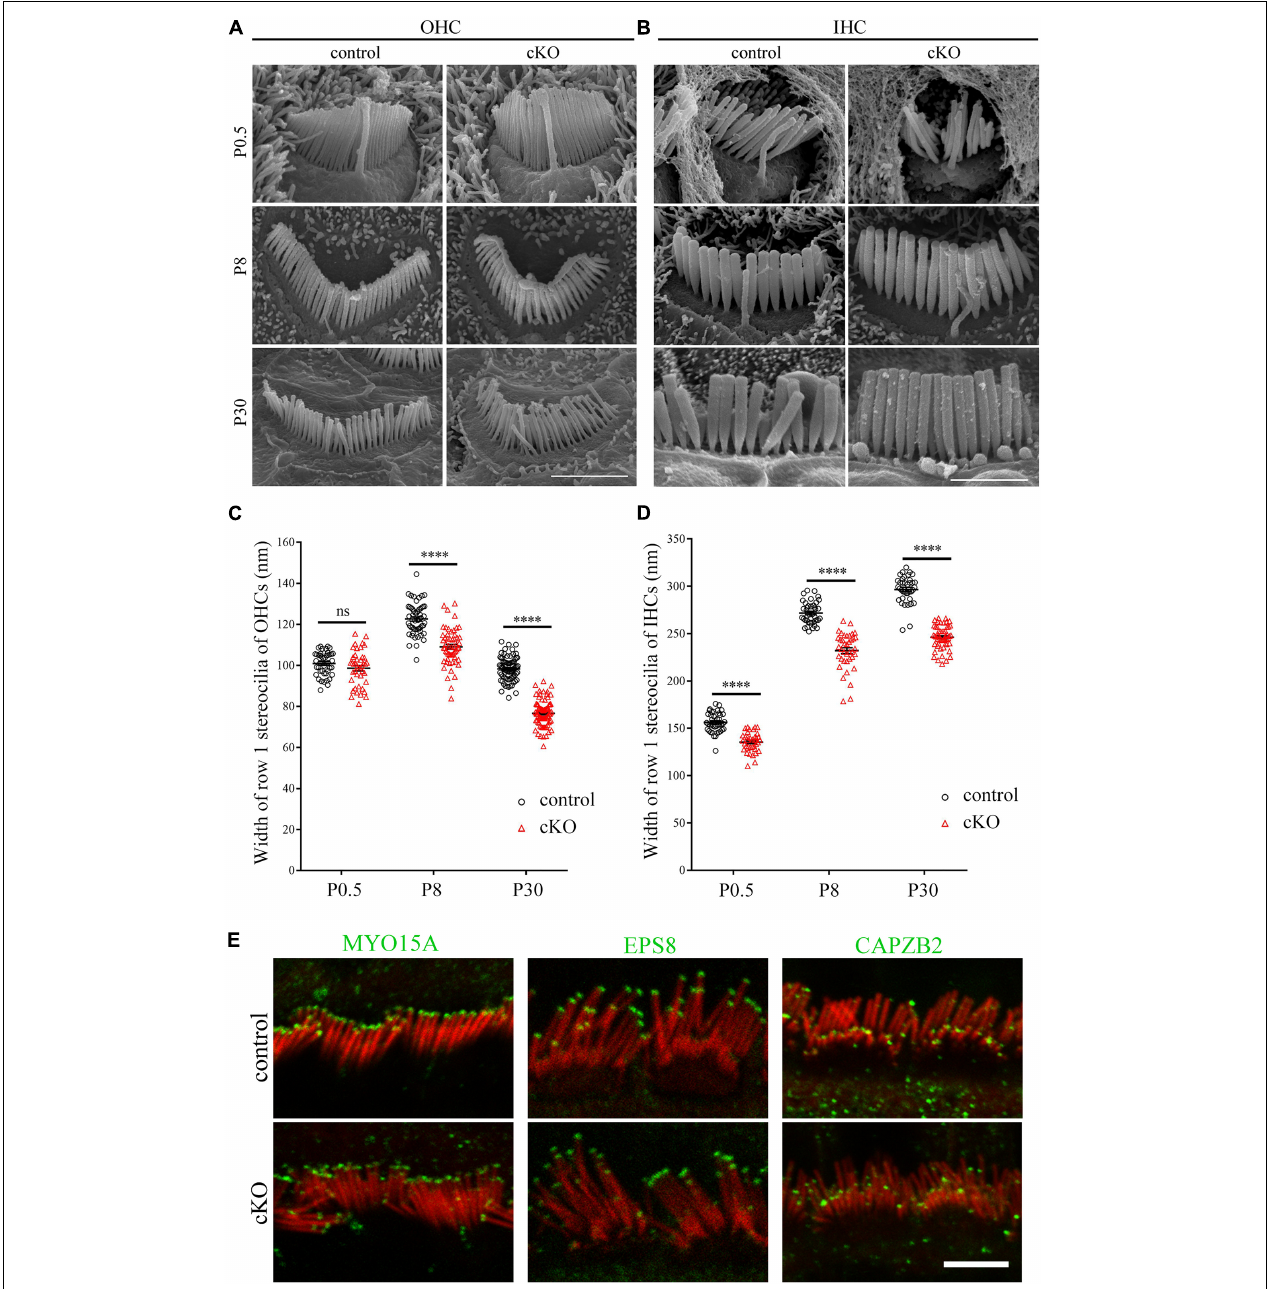
FIGURE 2 | Hair cell-specific Cdc42 inactivation leads to decreased stereocilia width. (A,B) High magnification SEM images of hair bundles (dorsal view) from OHCs (A) and IHCs (B) at different ages as indicated. Shown are images taken from the middle turns. Scale bars: 2 µ m. (C,D) Width of the tallest-row stereocilia in OHCs (C) and IHCs (D) at different ages as indicated were analyzed according to the results from (A,B) , respectively. For statistical analyses in (C,D) , images were randomly taken from at least 3 animals for each group. The bars indicate mean ± SEM values. **** P < 0.0001; ns, no significant difference. (E) Whole-mount immunostaining showing localization of MYO15A, EPS8 and CAPZB2 in IHCs of P9 control or cKO mice. TRITC-phalloidin (red) was used to visualize the stereociliary F-actin core. All images were taken from the apical turns of cochlea using a confocal microscope. Scale bar: 5 µ m.